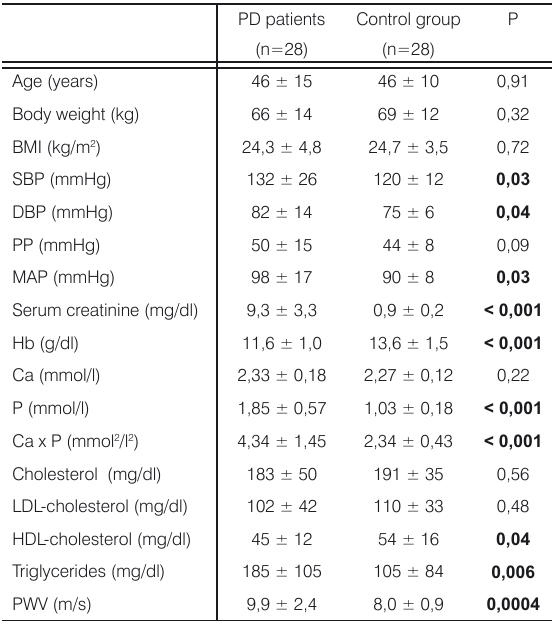
Table 1. Comparison of clinical and laboratory parameters and PWV between PD patients and control